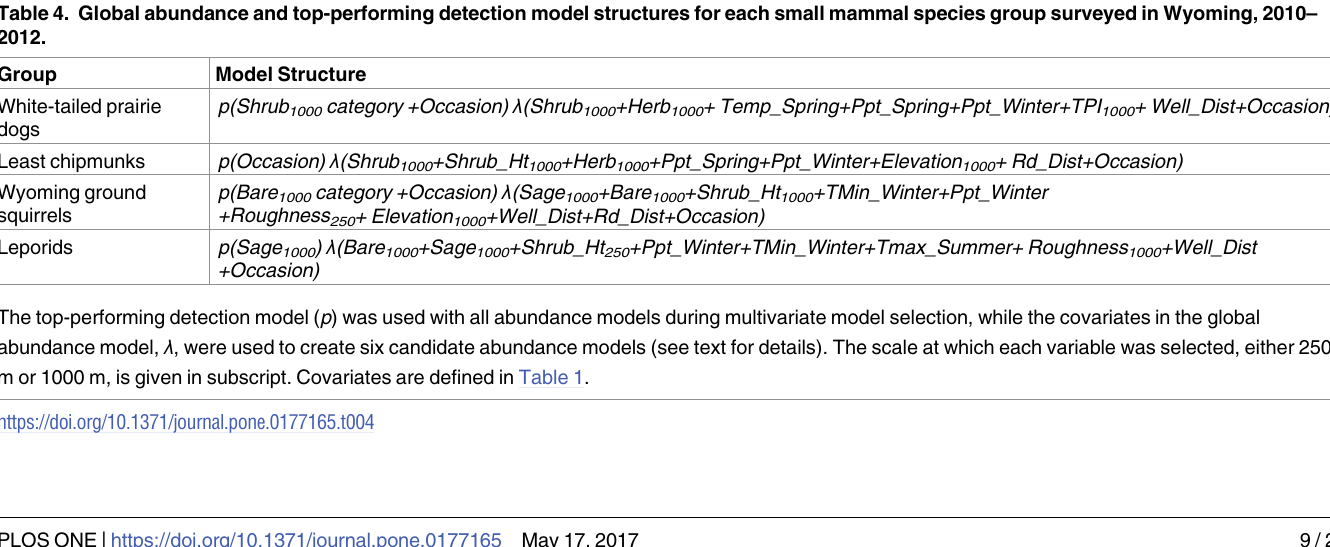
Table 4. Global abundance and top-performing detection model structuresfor each small mammal species group surveyedin Wyoming, 2010– 2012. Group Model Structure White-tailed prairie dogs